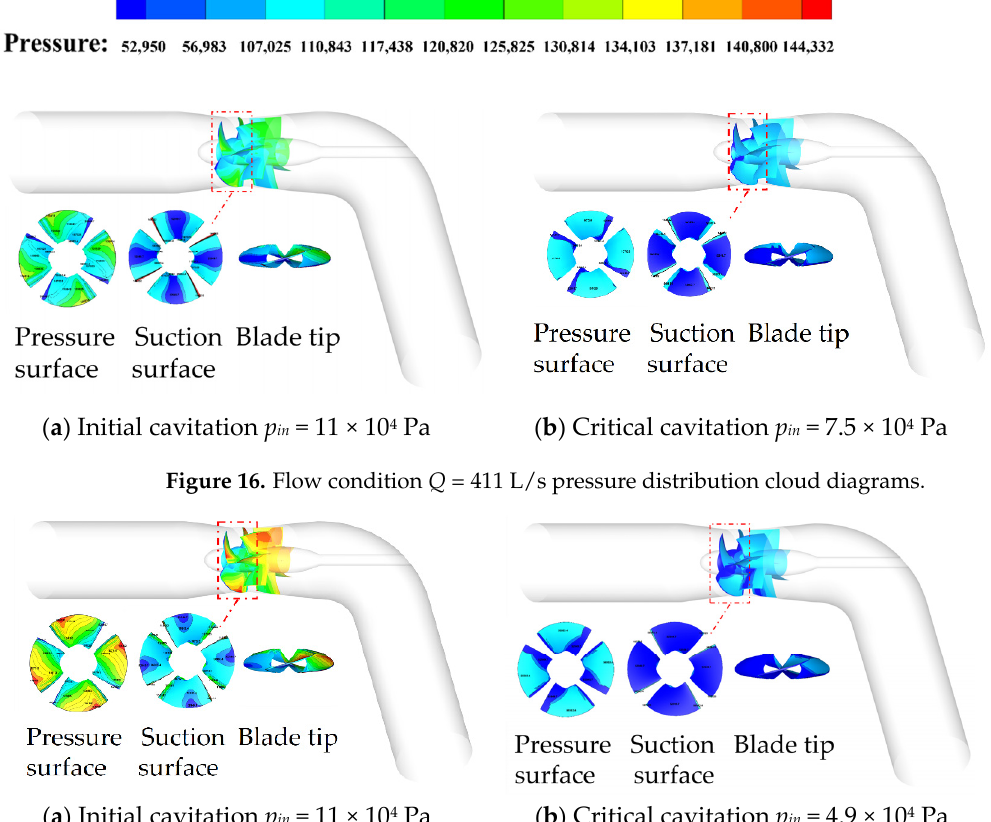
collated as shown in Figures 16–19.